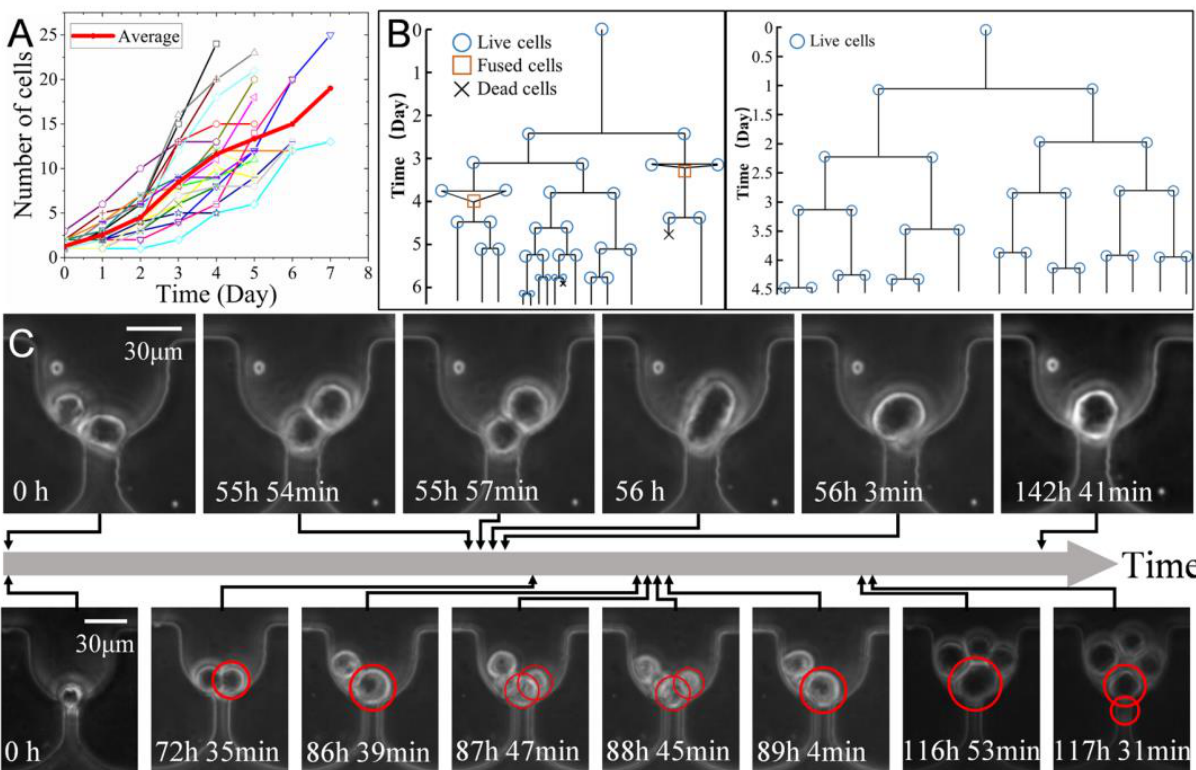
Figure 6. In situ clonal expansion of captured K562 cells. ( A ) The growth curves of 22 individual clones within 7 days. The line with dots shows the average of all clones. ( B ) The lineage trees of two clones. The line length suggests the division time. ( C ) Micro photos showing the one cell divided into two cells, which were fused into one cell dividing into two daughter cells later.